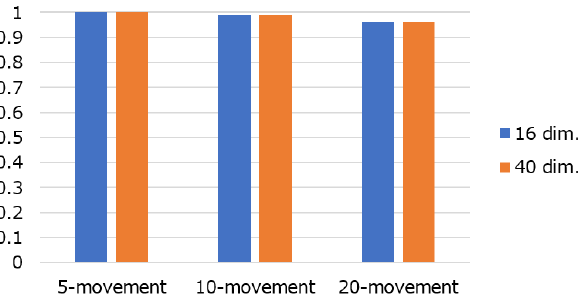
Figure 6. Results for gaze movement pattern in Evaluation 1. The value is the